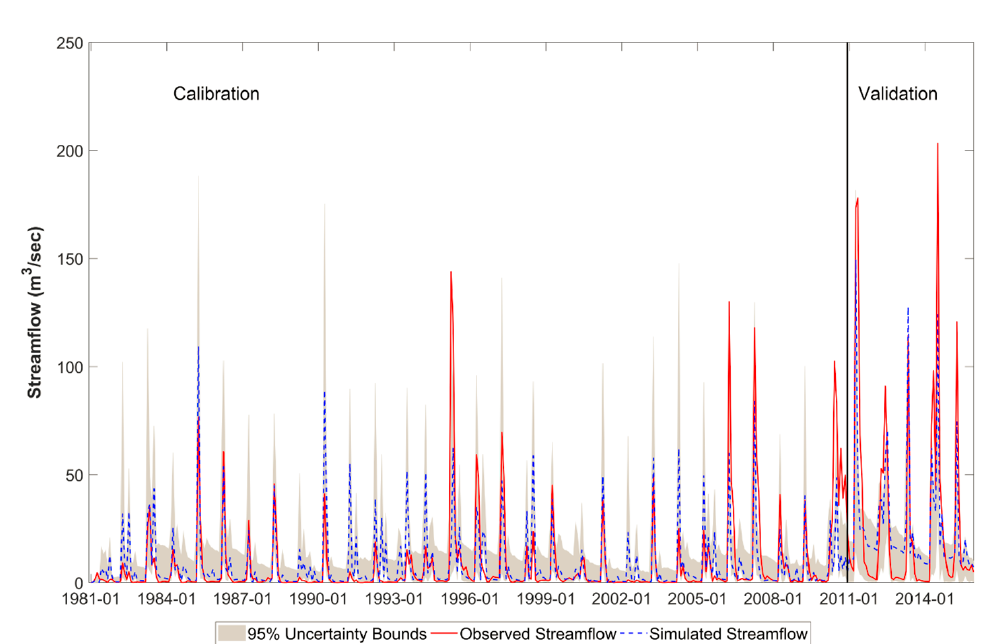
Figure 5 . Calibration (1981–2010) and validation (2011–2015) of baseline SWAT model at the catchment outlet (WSC ID: 05MD004). outlet (WSC ID: